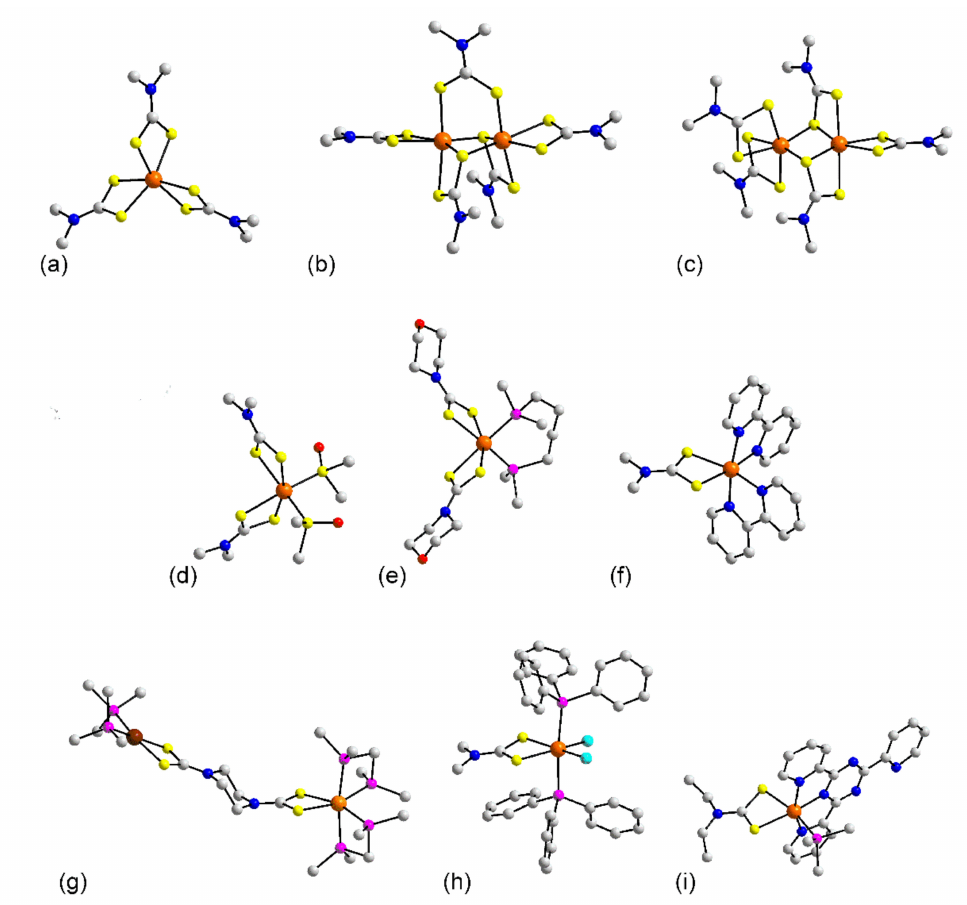
Figure 3. Molecular structures of ruthenium complexes: ( a ) Ru( L 8 ) 3 ( 1 ), ( b ) [Ru( L 8 ) 3 ] in the crystal of 4 , ( c ) [Ru 2 ( L 8 ) 3 ] in 5 , ( d ) Ru( L 8 ) 2 ((CH 3 ) 2 SO) 2 ( 6 ), ( e ) (dppb)Ru( L 79 ) 2 ( 10 ), ( f ) [Ru(bpy) 2 ( L 8 )] + in 11 , ( g ) [(dppm) 2 Ru( L 74 )Pd(PPh 3 ) 2 ] 2+ in 17 , ( h ) [(PPh 3 ) 2 Ru( L 8 )Cl 2 ] in 18 , and ( i ) [(PPh 3 )Ru(tptz)( L 24 )] + in 21 . In ( e , g , i ), only the ispo-C atoms of the phosphane bound phenyl rings are shown for clarity. Color code in this and subsequent crystallographic images: platinum-group element, orange; other heavy element, brown; chloride, cyan; sulfur, yellow; phosphorus, purple; oxygen, red; nitrogen, blue; carbon, grey; hydrogen, green. Non-participating H atoms are